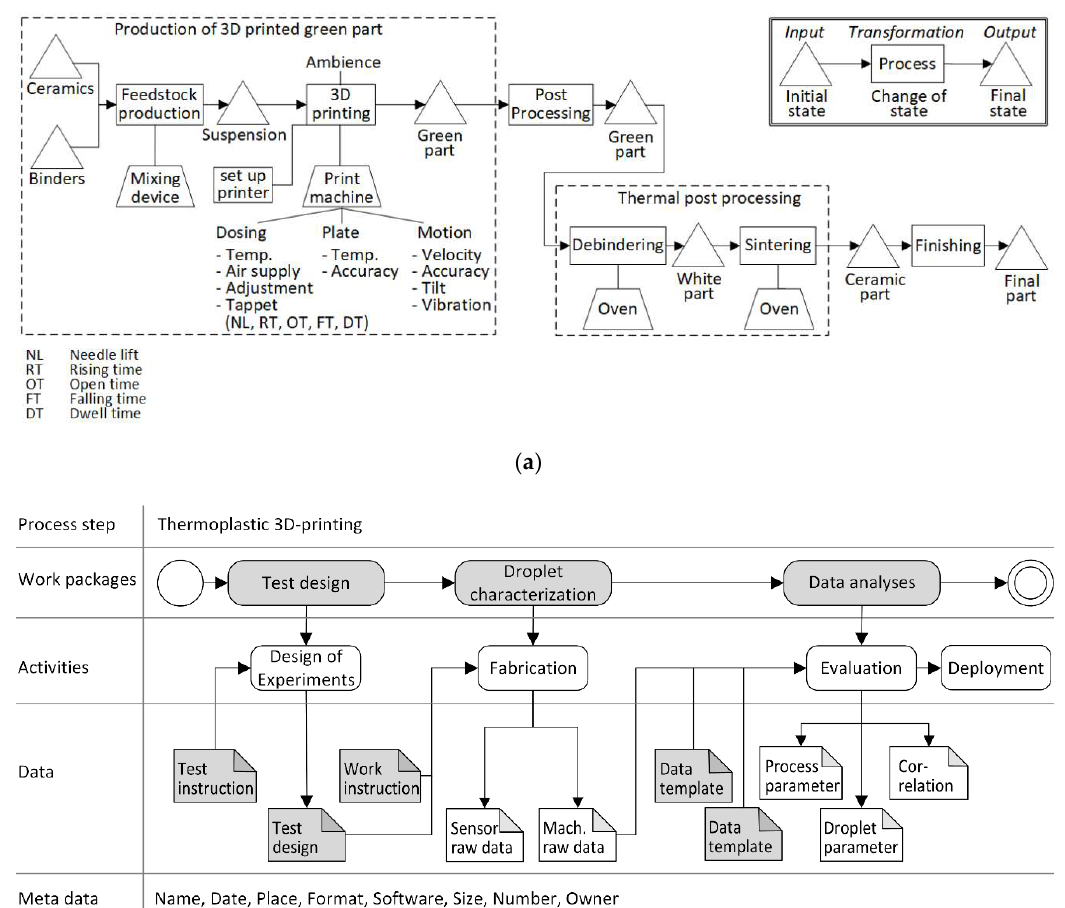
Figure 4. ( a ) Technological process chain for the production of a part using the CerAM MMJ and ( b ) the engineering workflow of the data collection for the process step of 3D printing.